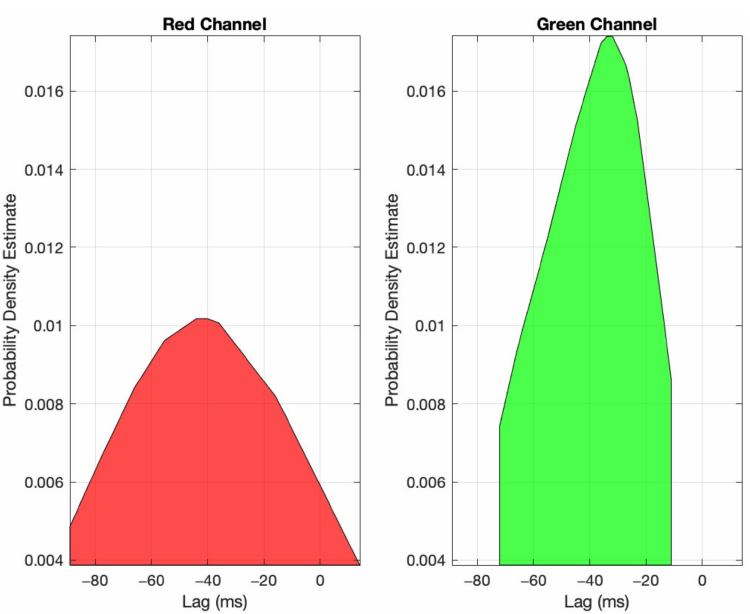
Figure 7. The distribution of temporal lag between glabrous and non-glabrous signals for the red and green channels, with negative lags representing glabrous leading non-glabrous.